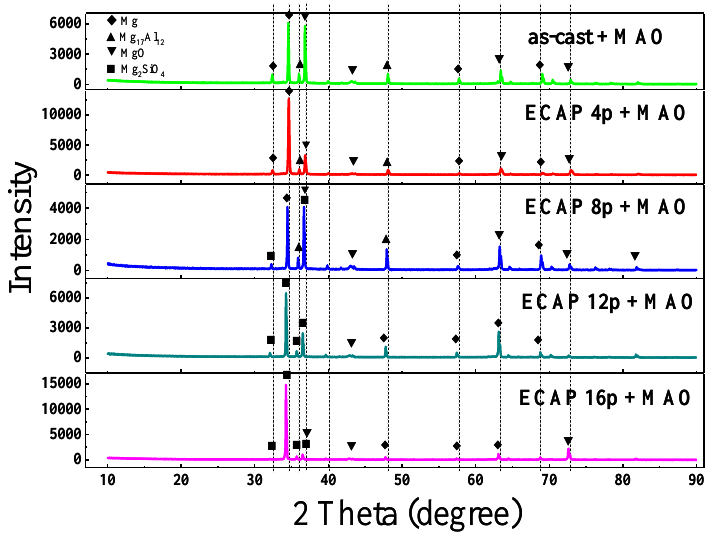
Figure 2. X-Ray diffraction patterns of micro-arc oxidation on the as-cast and ECAPed AZ91D magnesium alloys.